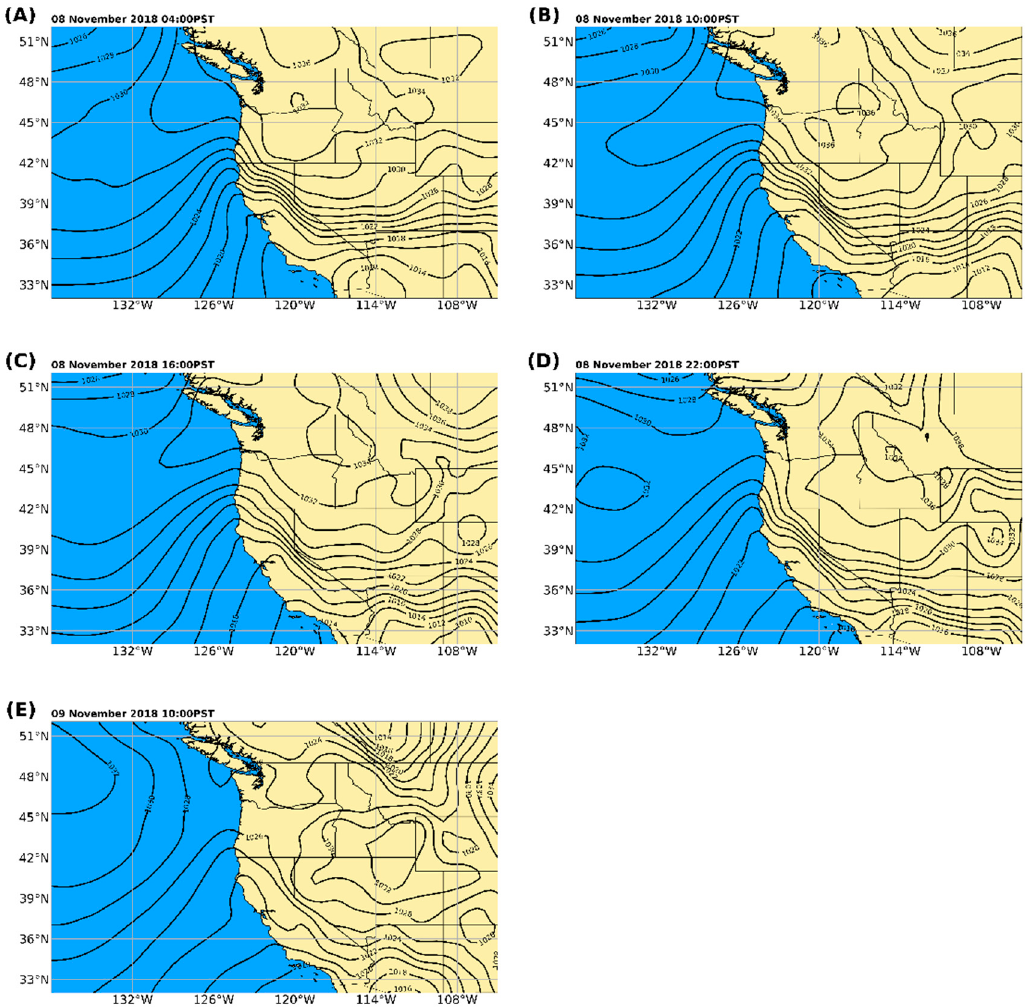
Figure 6. 0.5 ◦ NCEP GFS analysis with mean sea level pressure (MSLP) in black contours. ( A – D ) show the analysis from 04:00 PST 8 November 2018 through 22:00 PST 8 November 2018, every 6 h. ( E ) shows the analysis 12 h later at 10:00 PST 0 November 2018.